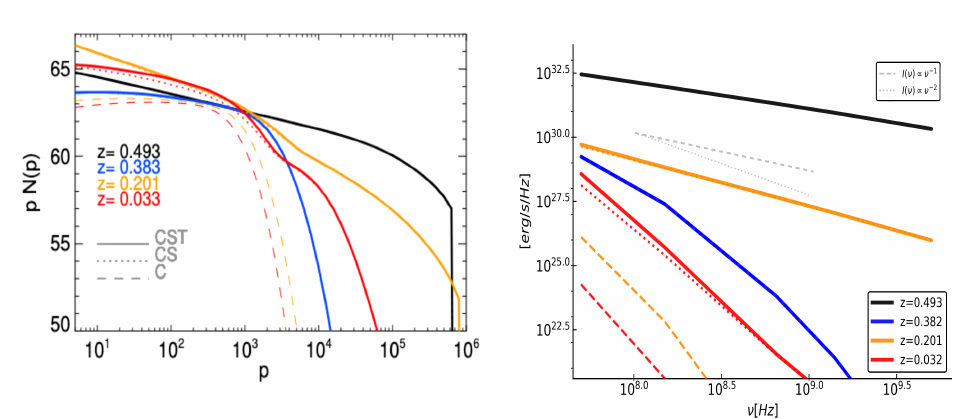
Figure 4. ( Left panel ): electron momentum spectra for four different epochs and for all tracers located within a r ≤ 1 Mpc radius from the moving cluster centre, considering the evolution of re-accelerated electrons seeded by radio jets, under the three investigated models for CRe energy evolution (C, CS, and CST). ( Right panel ): evolving radio emission spectra for the same families of electrons and epochs (same meaning of the different line styles—the three models give the same radio spectrum for the first two epochs, so all model lines are superimposed there), without observational cuts. The thin grey lines give two different radio slopes ( I ( ν ) ∝ ν − 1 and ∝ ν − 2 ) to guide the